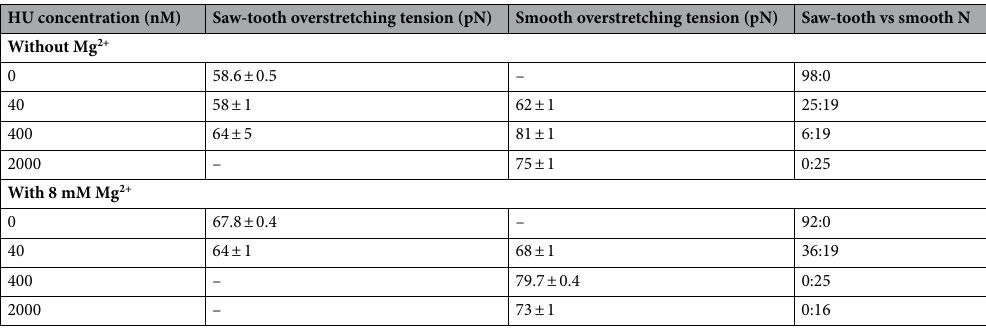
Table 1. The occurrence of saw-tooth vs smooth features on force-extension curves at high tension. Error are SEM (standard error of the mean).